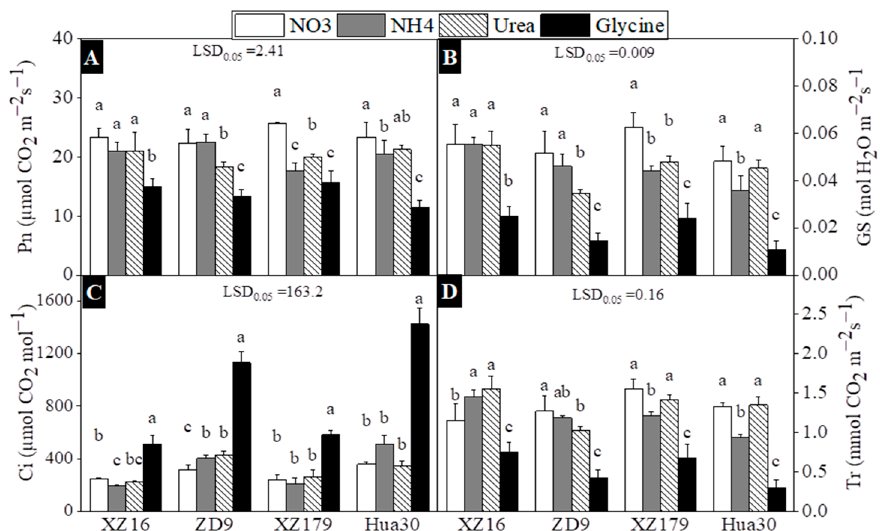
Figure 3. Effects of different nitrogen forms on CO 2 assimilation rate (Pn) ( A ), stomatal conductance (Gs) ( B ), intercellular CO2 (Ci) ( C ) and transpiration rate (Tr) ( D ) of four barley genotypes at 28 day after treatment (stage 4 and day 42 on BBCH scale). Values are expressed as mean ± SD ( n = 4). Significant difference ( p < 0.05) between treatments is indicated by different letters. LSD.05 values in the figures are for the comparison between genotypes.